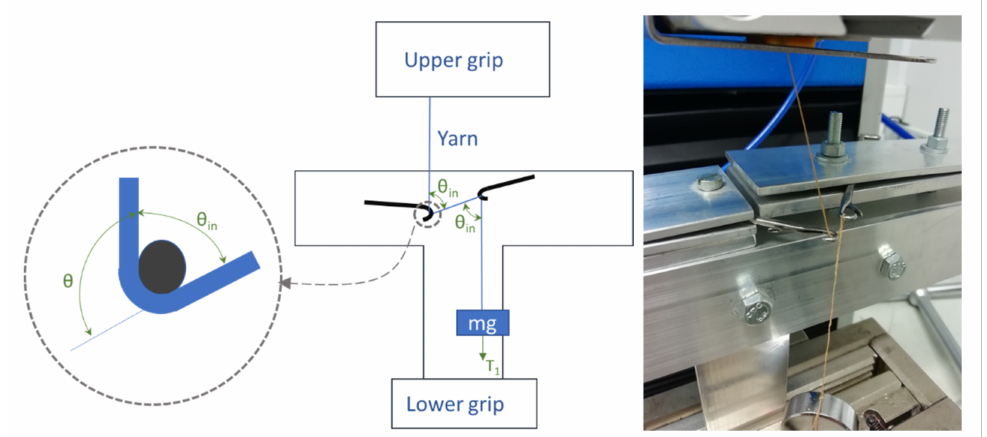
Figure 4. A schematic and a picture of the rig were used with a tensile tester to determine the coefficient of metal yarn